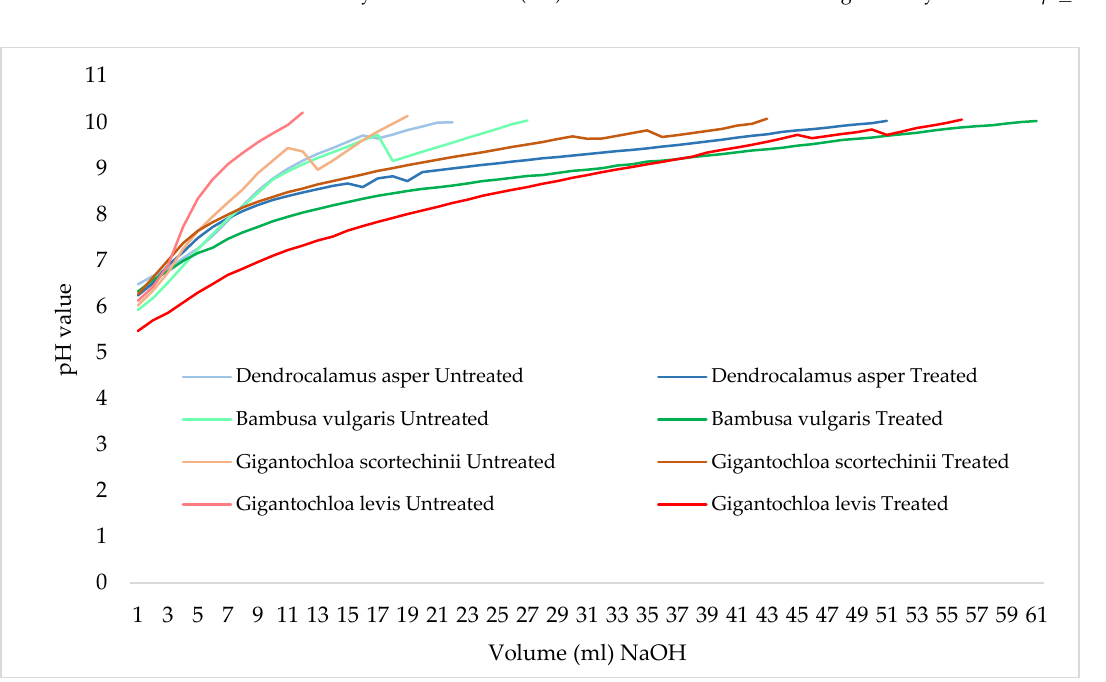
Figure 7. Stability of untreated and treated bamboo strips of four selected species in alkaline condi- tions.